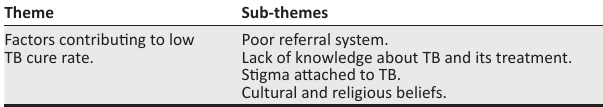
TABLE 1: Summary of